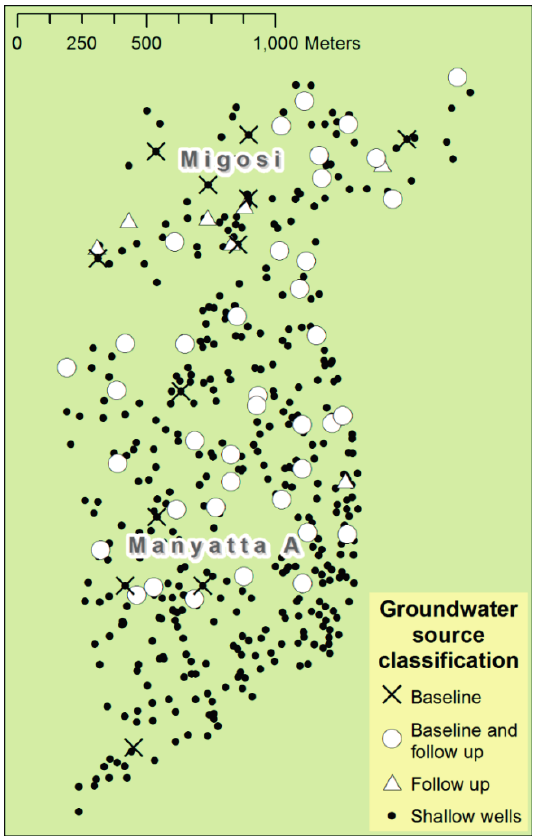
Figure 2. Map showing the locations of wells in Manyatta A and Migosi sampled during the baseline (1998–2004) and follow-up surveys